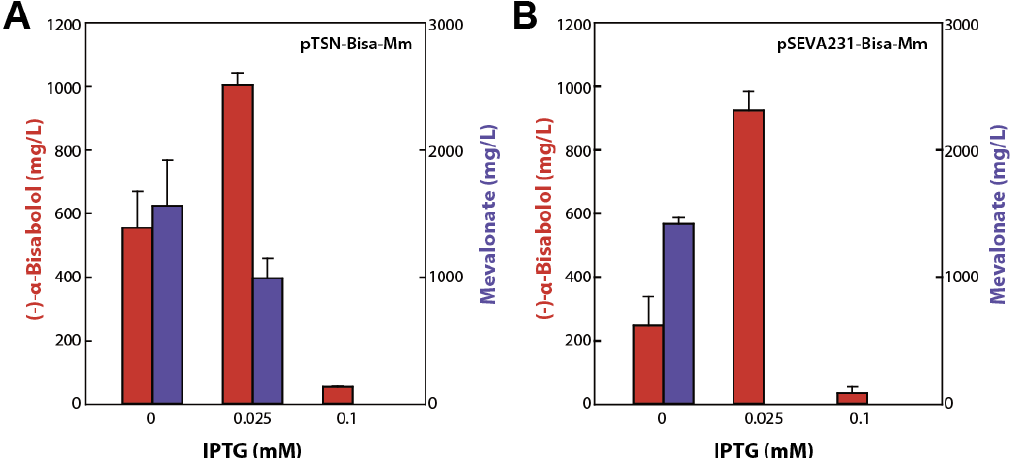
Figure 3. Effect of IPTG on (−)-α-bisabolol production. The concentrations of (−)-α-bisabolol and MVA Figure 3. E ff ect of IPTG on ( − )- α -bisabolol production. The concentrations of ( − )- α -bisabolol and MVA produced by the E. coli DH5α harboring pTSN-Bisa-Mm, a high-copy plasmid ( A ) or pSEVA231-Bisa- producedbythe E.coli DH5 α harboringpTSN-Bisa-Mm, ahigh-copyplasmid( A )orpSEVA231-Bisa-Mm, Mm, a medium-copy plasmid ( B ). Cells were grown in TB medium containing 10 g/L glycerol and 20% a medium-copy plasmid ( B ). Cells were grown in TB medium containing 10 g / L glycerol and 20% (v / v) (v/v) of n -dodecane in the presence of different IPTG concentrations (0, 0.025 and 0.1 mM) at 30 °C for of n -dodecane in the presence of di ff erent IPTG concentrations (0, 0.025 and 0.1 mM) at 30 ◦ C for 72 h. 72 h. The error bars represent the standard deviation of the concentrations of (−)-α-bisabolol and MVA The error bars represent the standard deviation of the concentrations of ( − )- α -bisabolol and MVA from from three biological replicates. three biological